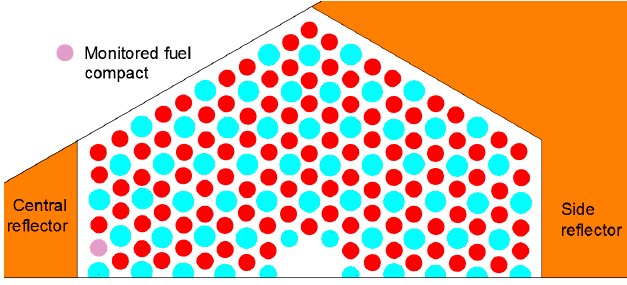
Figure 7. Compact monitored for the 239 Pu build up analysis.